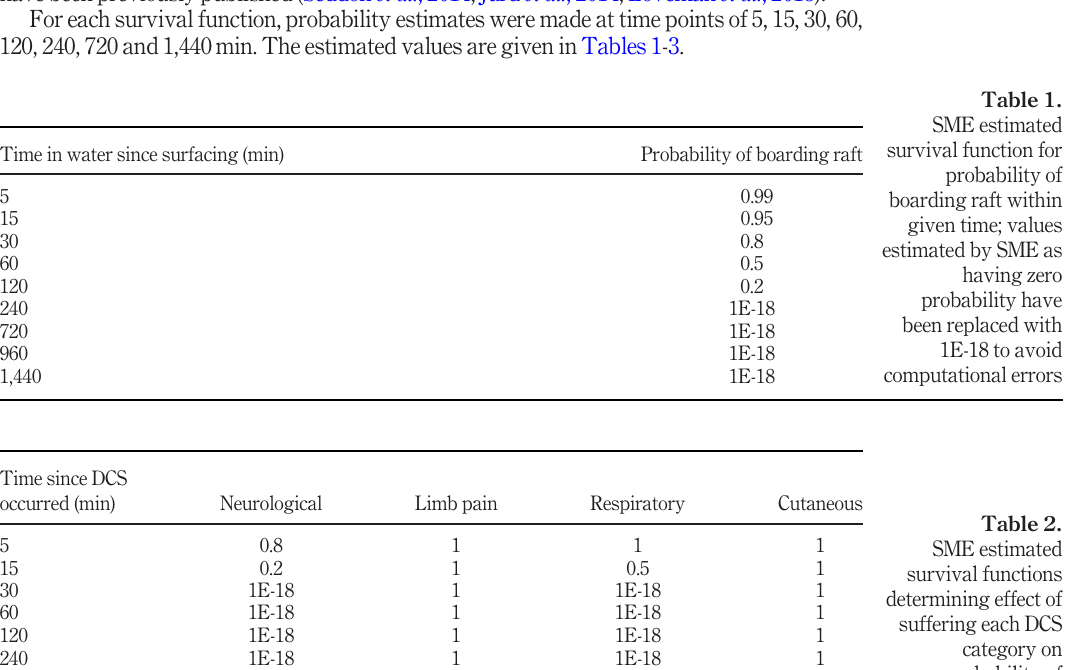
Table 2. SME estimated survival functions determining effect of suffering each DCS category on probability